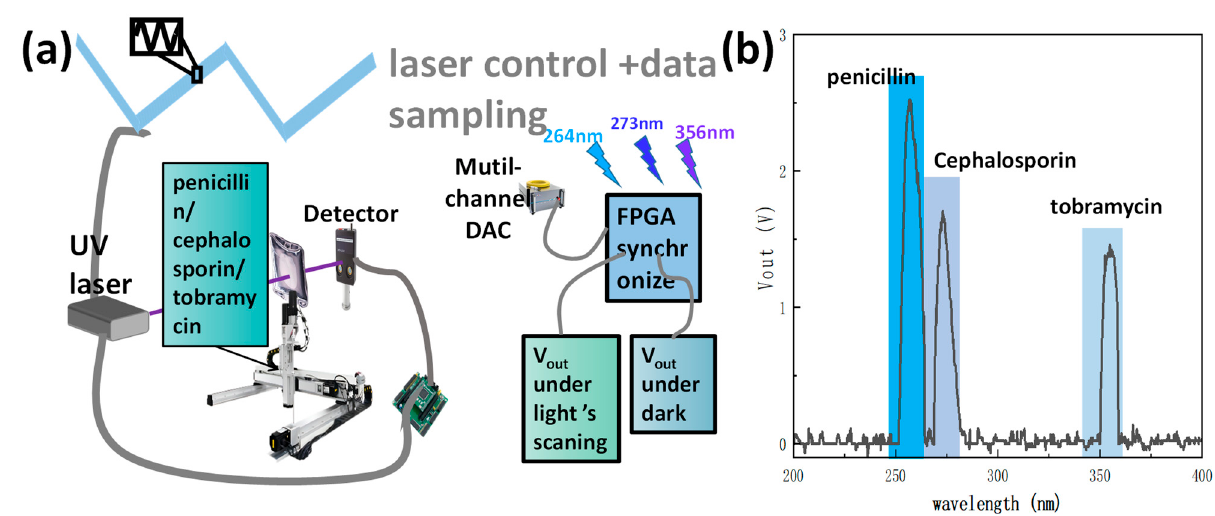
Figure 5. ( a ) Schematic and contrast images of the solute sensing systems; ( b ) real-time multiplexed sensing of a solute mixture consisting of 500 µg/mL penicillin, 500 µg/mL cephalosporin, and 500 µg/mL tobramycin.